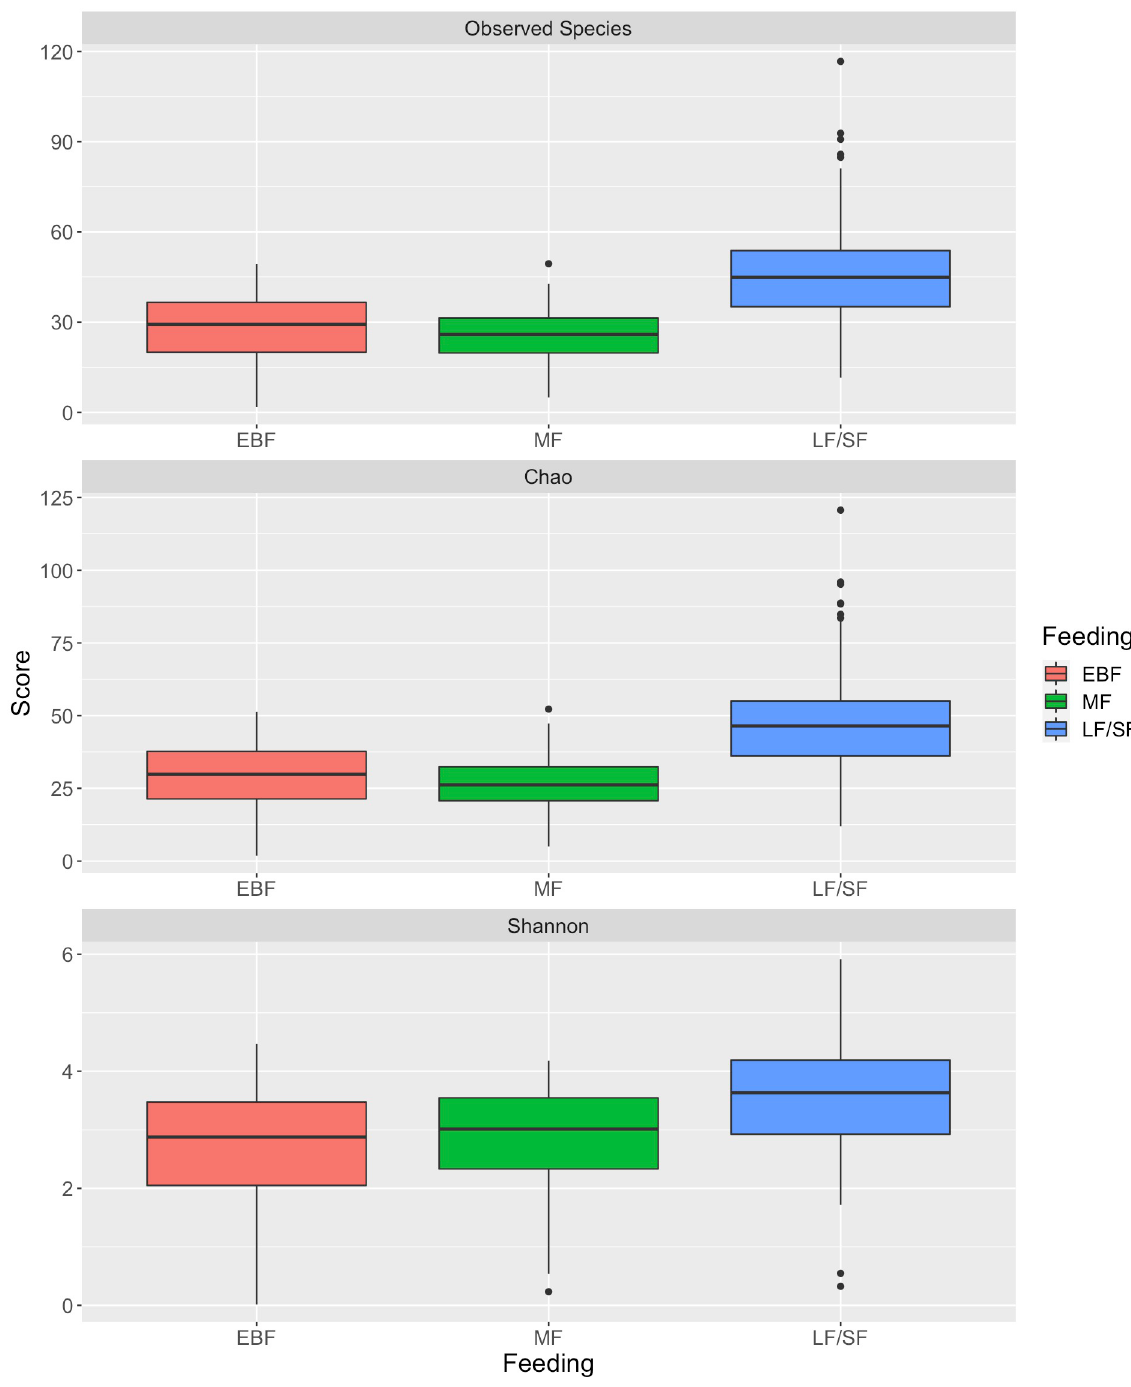
Fig 3. Alpha diversity linked to feeding method for samples collected from all babies. Samples were grouped into EBF (exclusive breastfeeding), MF (mixed feeding: breast milk plus formula milk) and weaning samples following the introduction of local food plus solid foods (LF/SF). EBF and MF samples were significantly different to the LF/SF samples (p < 0.01; Kruskal Wallis followed by Dunn Post-Hoc analysis).